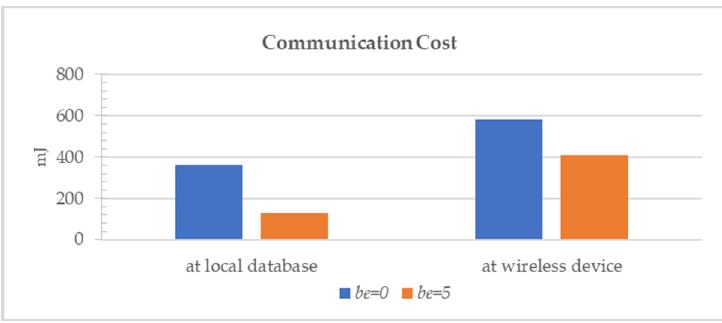
Figure 12. Communication cost of a query with fundamental operations.